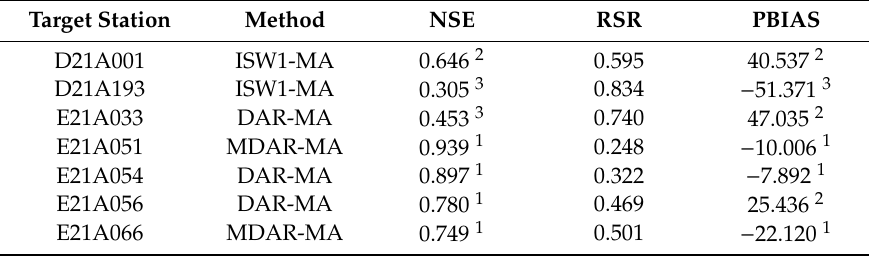
Table 15. Performance evaluation of the best statistical method with the MA for each target station in the Upper Euphrates